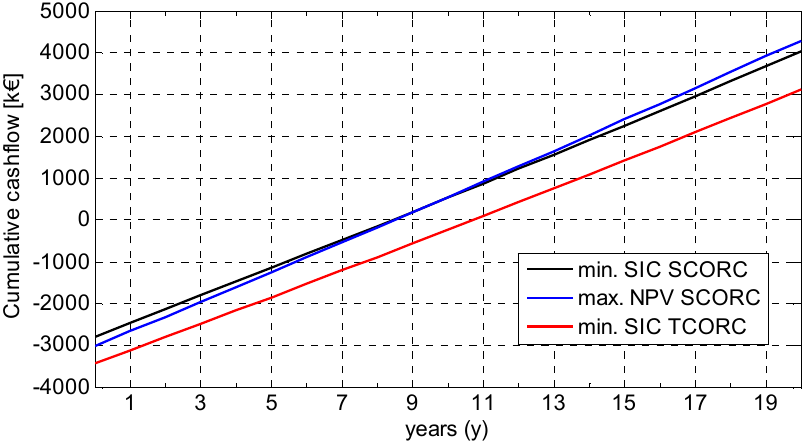
Figure 16. Cumulative cash flow for min. SIC SCORC, min. SIC TCORC and max. NPV